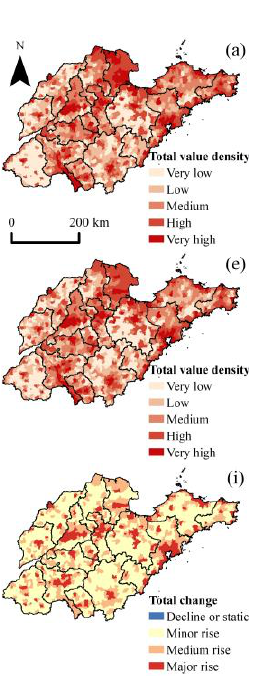
Figure 4. Distributive pattern of the land use functional value density and the change from 2009 to 2018. ( a – d ): The value density in 2009 classified by quantiles; ( e – h ): The value density in 2018 classified by quantiles; ( i – l ) : The value density changes from 2009 to 2018, with “major rise” for the first quarter, “medium rise” for the second quarter, and “minor rise” for the rest risen townships.